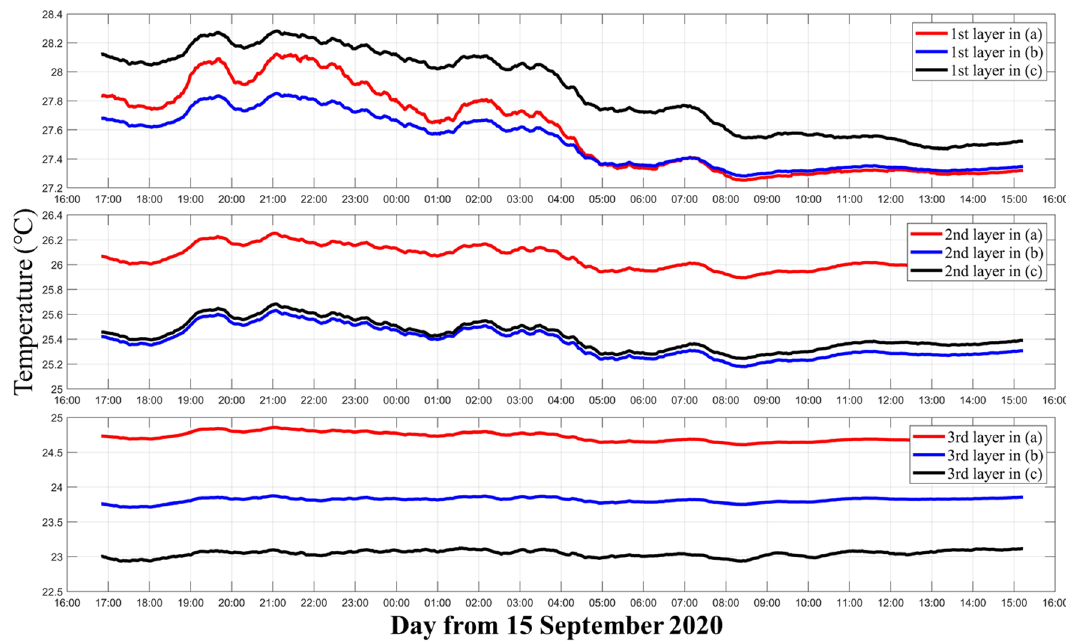
Figure 7. Moving average of the three layers’ temperature. The red, blue, and black curves indicate the three layers’ temperatures corresponding to Figure 6a–c, respectively.